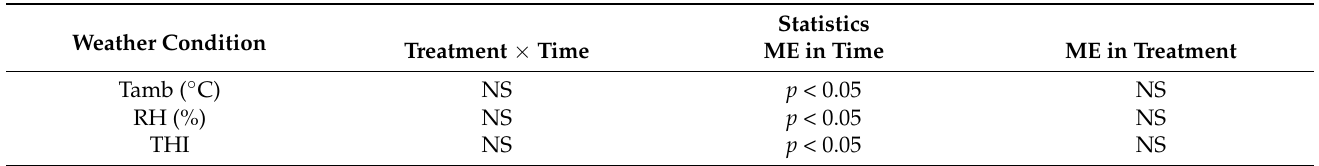
Table 2. Statistics of ambient temperature (Tamb), relative humidity (RH), and temperature–humidity index